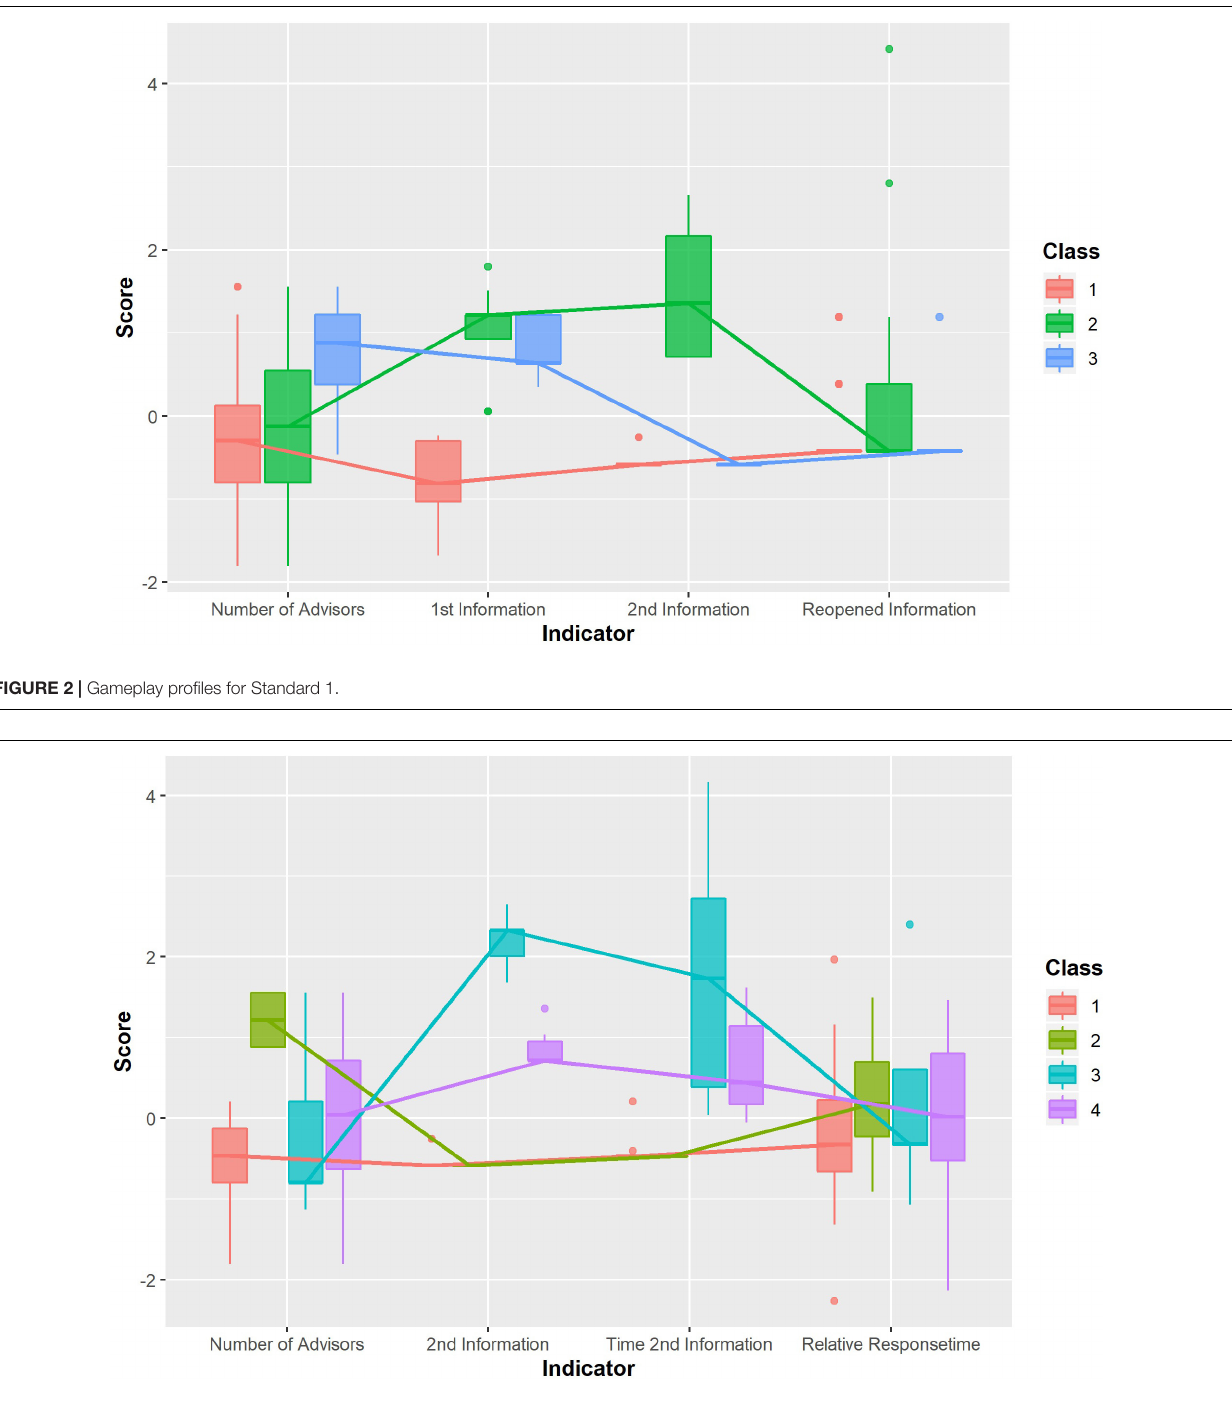
FIGURE 3 | Gameplay profiles for Standard